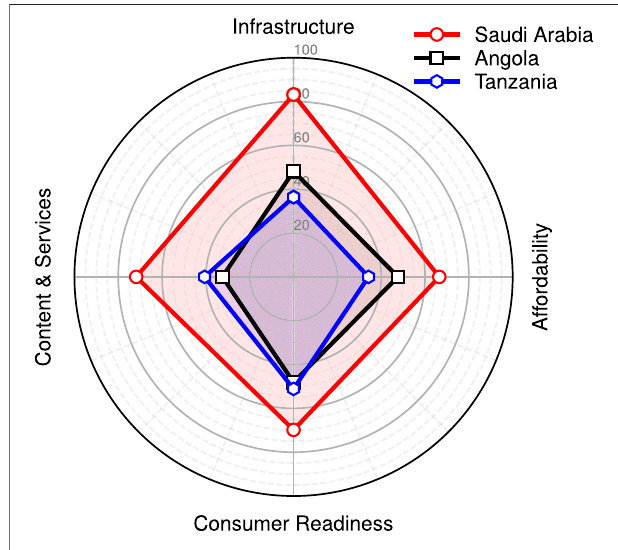
FIGURE 3 | ICT statistics over the three considered countries: Saudi Arabia, Angola, and